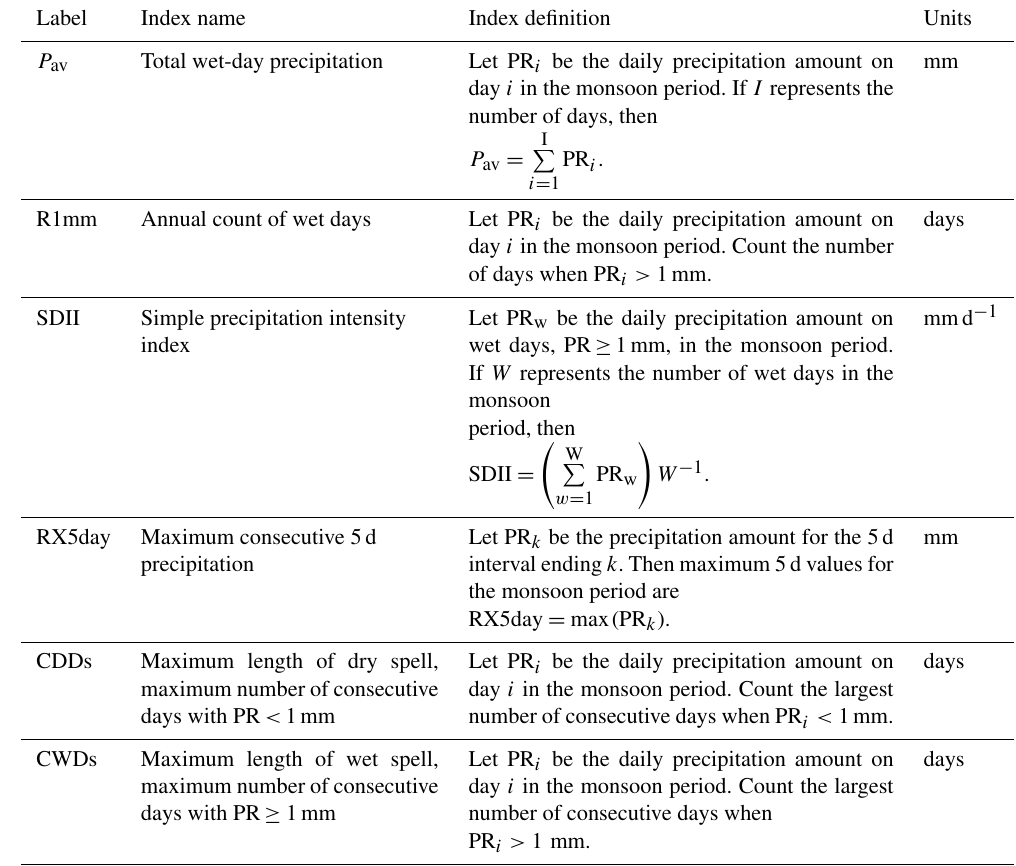
Table 2. Definition and description of land monsoon indices during the monsoon period used in this study.